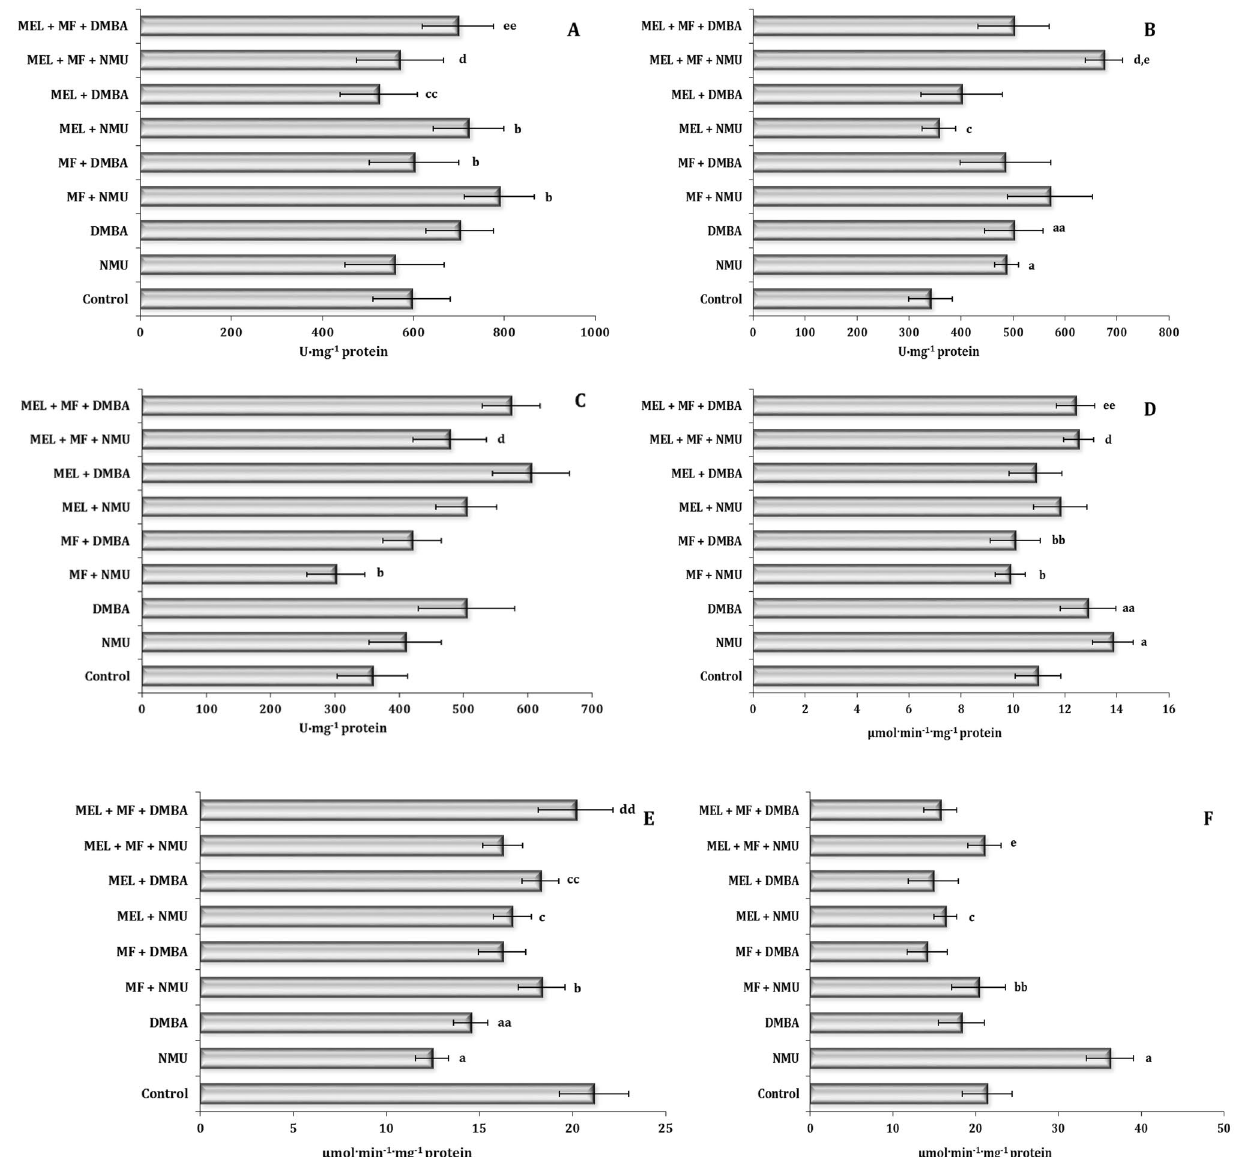
Figure 2. Superoxide dismutase activity (U mg −1 protein) in the liver ( A ), heart ( B ), spleen ( C ) and catalase activity (μmol min −1 ·mg −1 protein) in the liver ( D ), heart ( E ) and spleen ( F ) of female Sprague–Dawley rats subjected to a high-fat diet in the mammary carcinogenesis model induced by N -methyl- N -nitrosourea (NMU) or dimethylbenzanthracene (DMBA). Metformin (MF) or melatonin (MEL) was administrated alone and in combination (MF + MEL). Data are expressed as means ± S.D. Significant differences P < 0.05 are designated as follows: a—NMU group vs. control group; aa—DMBA group vs. control group; b—MF + NMU vs.